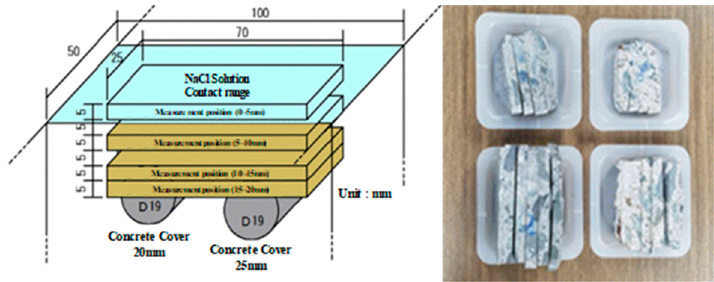
Figure 6. Test specimen collection method for measuring the amount of chloride in concrete.